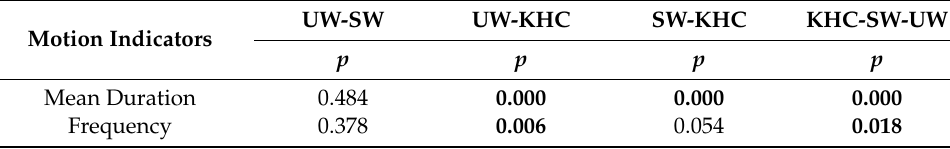
Figure 8. The mean duration of joints in three postures. UW—upright walking; SW—stoop walking; KHC—knee and hand crawling. Table 3. Relationship among postures with motion-capture